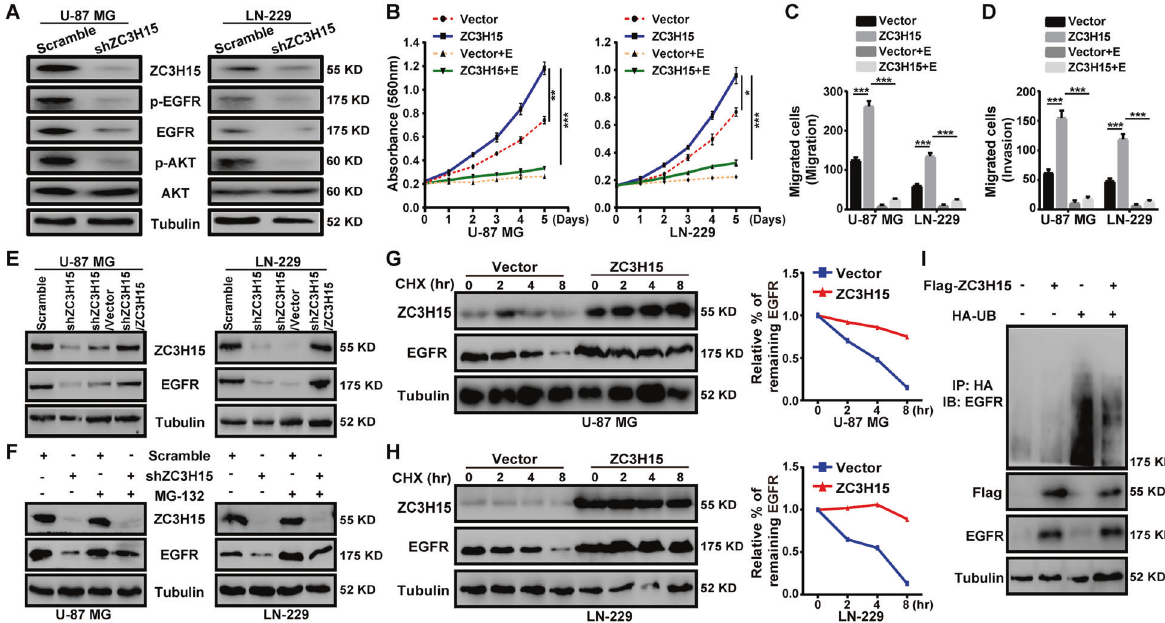
Fig. 3 ZC3H15 activates the EGFR-mediated signaling pathway by increasing EGFR protein stability. A Western blot analysis was performed to detect the expression of EGFR signaling proteins (EGFR, p-EGFR, AKT, p-AKT) of GBM cells. B The inhibitory effect of EGFR inhibitor-erlotinib on the proliferation activity in control or ZC3H15 overexpression cells. C , D The inhibitory effect of EGFR inhibitor-erlotinib on the invasion and migration in control and ZC3H15 overexpression cells. The number of cells invaded and migrated were counted and analyzed. E Western blot analysis was performed to detect the protein expression of EGFR in the indicated cells. F Cells were treated with MG- 132 for 8 h before harvesting to detect the protein level of EGFR in the indicated cells. G , H CHX treatment for time gradient (0 h, 2 h, 4 h, 8 h) with the ZC3H15 overexpression and control group. To determine whether ZC3H15 could stabilize EGFR. The gray value was calculated by ImageJ. I HA-tagged Ub plasmid and Flag-tagged ZC3H15 plasmid were co-transfected into the cells. The ubiquitinated EGFR proteins were pulled down with anti-HA antibody and immunoblotted with ant-EGFR antibody. All data were expressed as mean ± SD. Student ’ s t test was performed to analyzed signi fi cance. * P < 0.05, ** P < 0.01, *** P < 0.001.